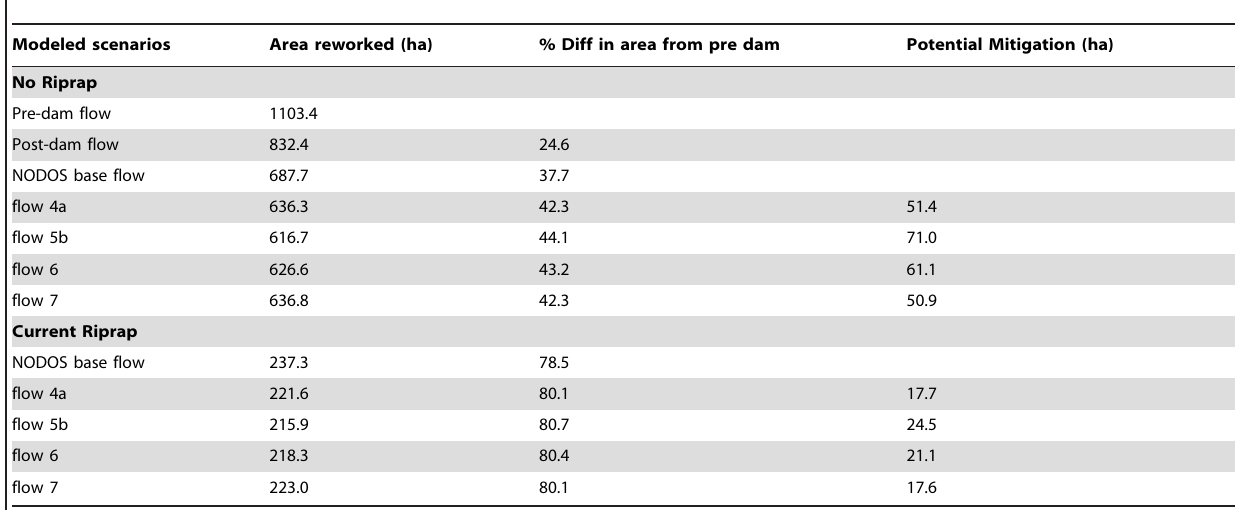
Table 3. Comparison of area reworked by river channel migration for seven flow scenarios (see Table 1) with and without riprap over a 130-year